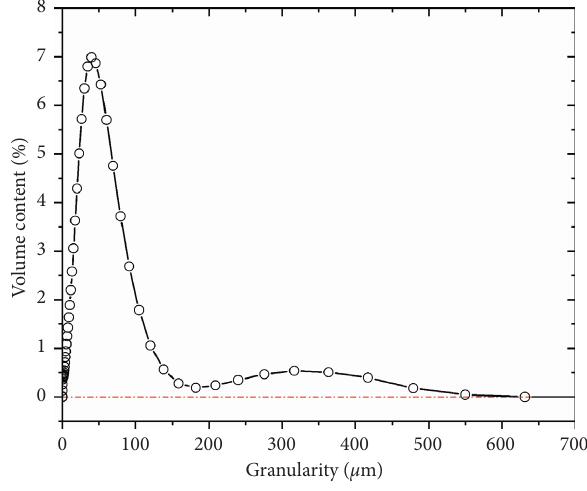
Figure 3: Soil particle size distribution curve. Table 1: Physical properties of soil